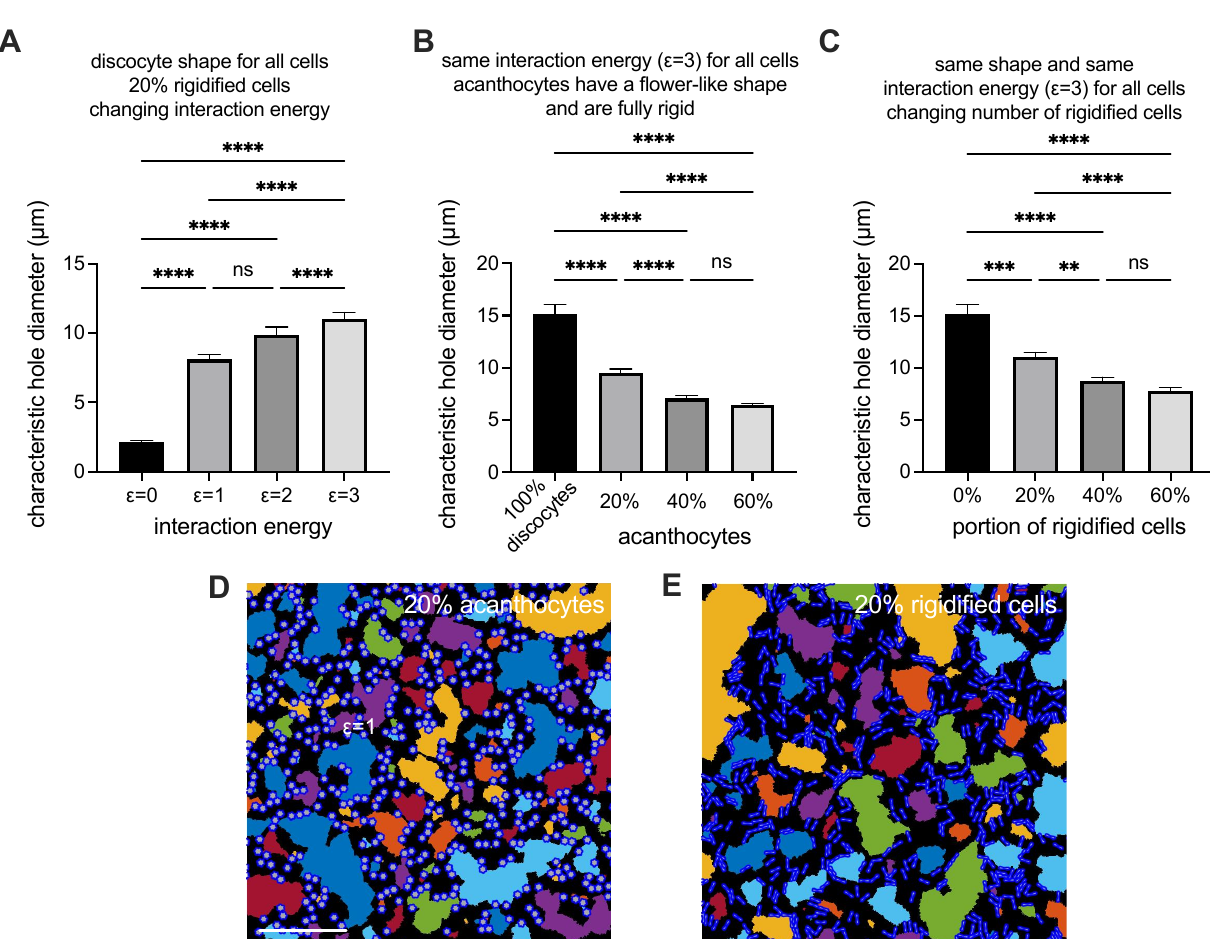
Figure 4. 2D modeling of RBC aggregation to better understand the dependence of characteristic hole size on the aggregation strength and fraction of acanthocytes. The larger the hole size, the faster the ESR. ( A ) Panel A shows hole sizes when only the interaction energy varies. An increase in the interaction energy mimics an increase in the plasma protein concentration, mainly the fibrinogen. ( B ) Panel B represents the situation of a variable number of acanthocytes, whereas acanthocytes have a different shape and are completely rigid. ( C ) Panel C depicts the situation when the interaction energy is constant, and all cells have the same discocyte shape, but the number of rigidified cells increases. ** refers to a significance level of p < 0.01, *** to p < 0.001 and **** to p < 0.0001. The abbreviation ns stands for not significant. ( D , E ) are example images for 20% acanthocytes and 20% rigidified cells respectively, as presented in panels ( B , C ). For a better visualization, the holes are marked in a variety of false colors. The scale bar refers to 100 µ